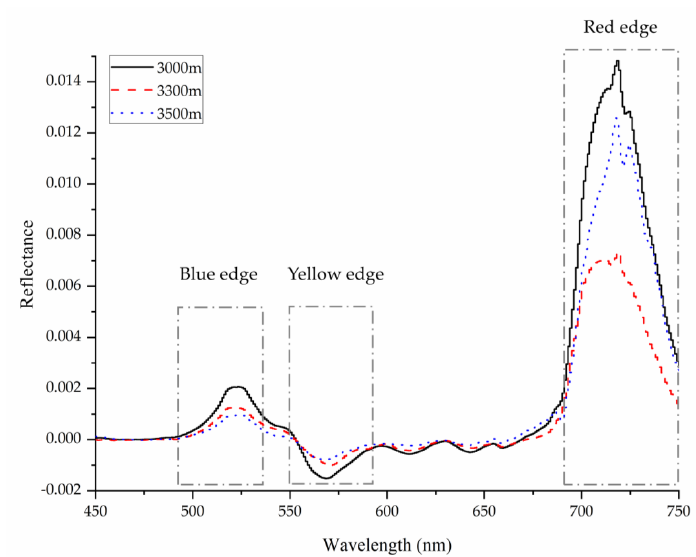
Figure 5. The first derivative spectral curves of the Quercus aquifolioides leaves at different altitudes.